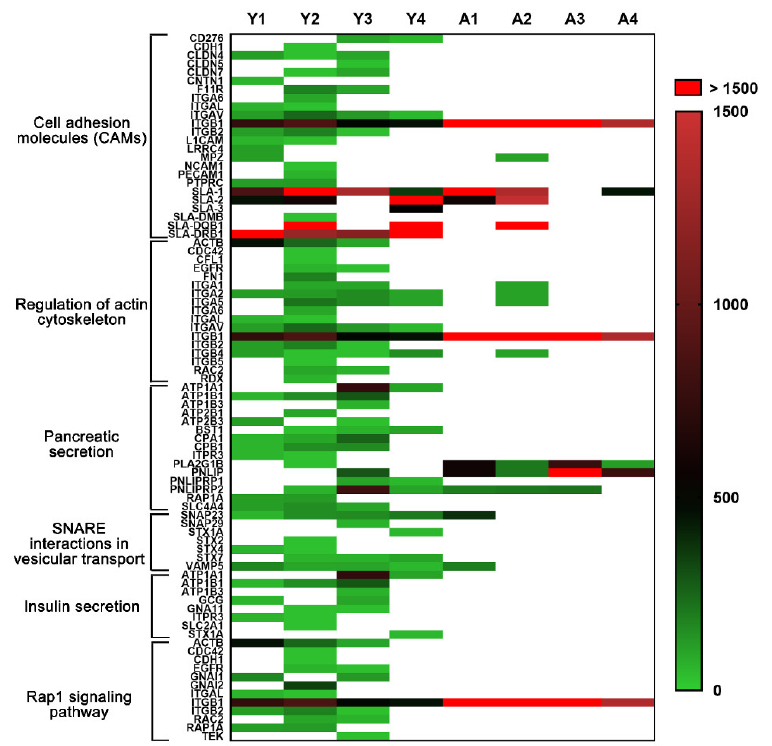
Figure 6. Heatmap of extracellular proteins in six enriched pathways identified in young ( n = 4) or adult ( n = 4) dpECM. Columns represent different dpECM samples from young (Y) or adult (A) pigs, whereas rows represent different gene symbols of ECM proteins. Several proteins were found in more than one pathway. The relative abundance of each protein is depicted by the heatmap color scale. White color stands for the proteins not detected in the samples.